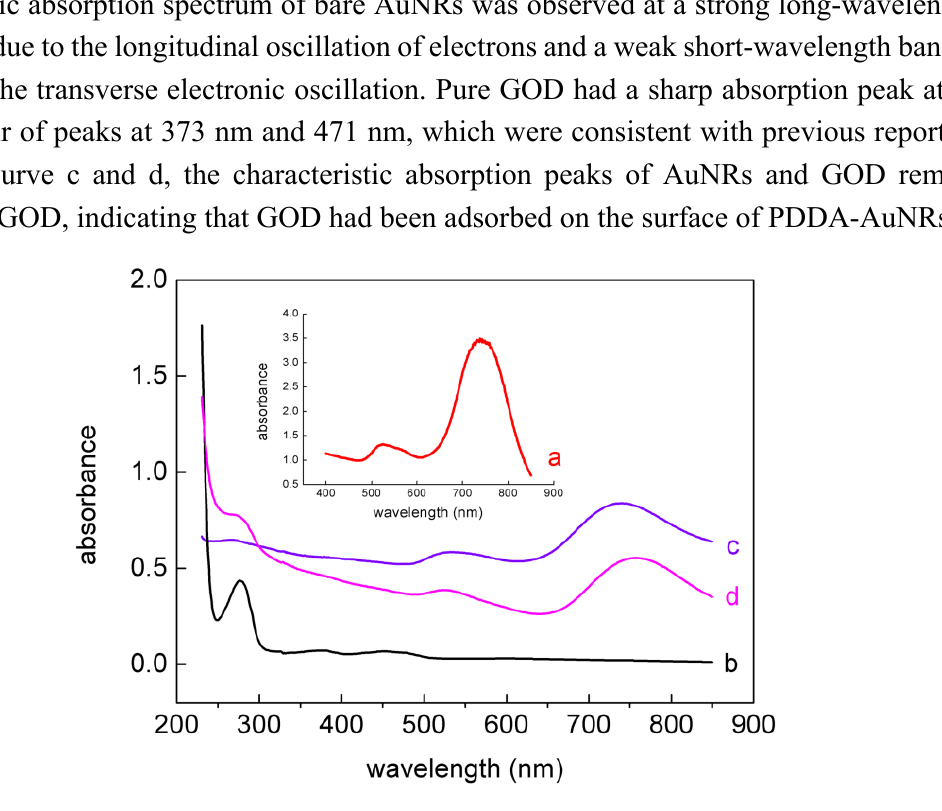
Figure 3. UV-Vis absorption spectra of ( a ) bare AuNRs; ( b ) pure GOD; ( c ) PDDA-AuNRs; and ( d )